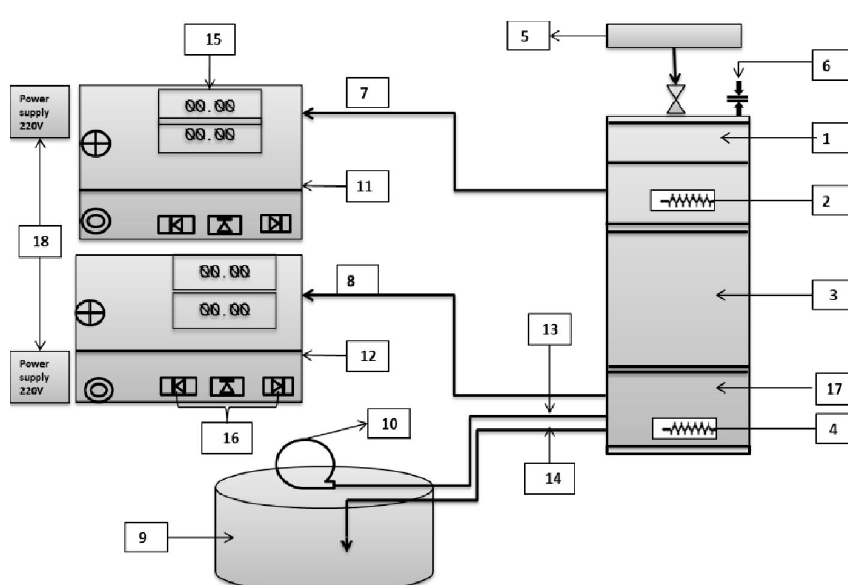
FIG. 2. BASIC EXPERIMENTAL SETUP LAYOUT OF THERMAL CONDUCTIVITY MEASUREMENT APPARATUS